Question: State the chart type depicted above.
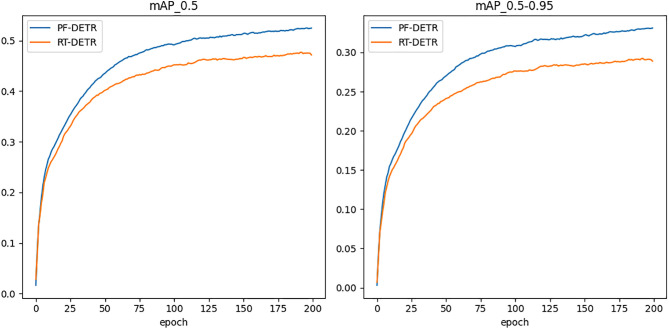
Answer: line